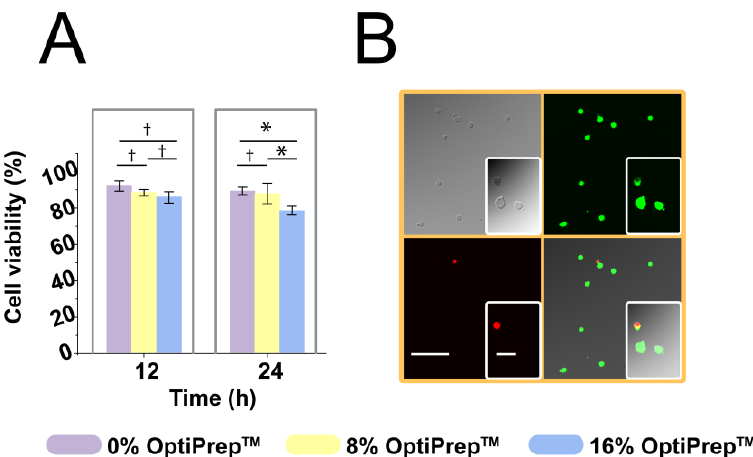
Figure 4. THP-1 cells maintained high viability with the presence of OptiPrep ™ over 24 h inside the droplets. ( A ) Cell viability at two time points: 12 h and 24 h; * represents p < 0.05; † represents no significant di ff erence; error bars represent the standard deviation. ( B ) Images showing cell viability. Measurement of cell viability was performed with the live / dead assay, live cells were stained with Calcein-AM (green) and dead cells with EtD-III (red); scale bar = 100 µ m for images obtained by a 20 × objective; scale bar = 10 µ m for insets obtained by a 100 ×